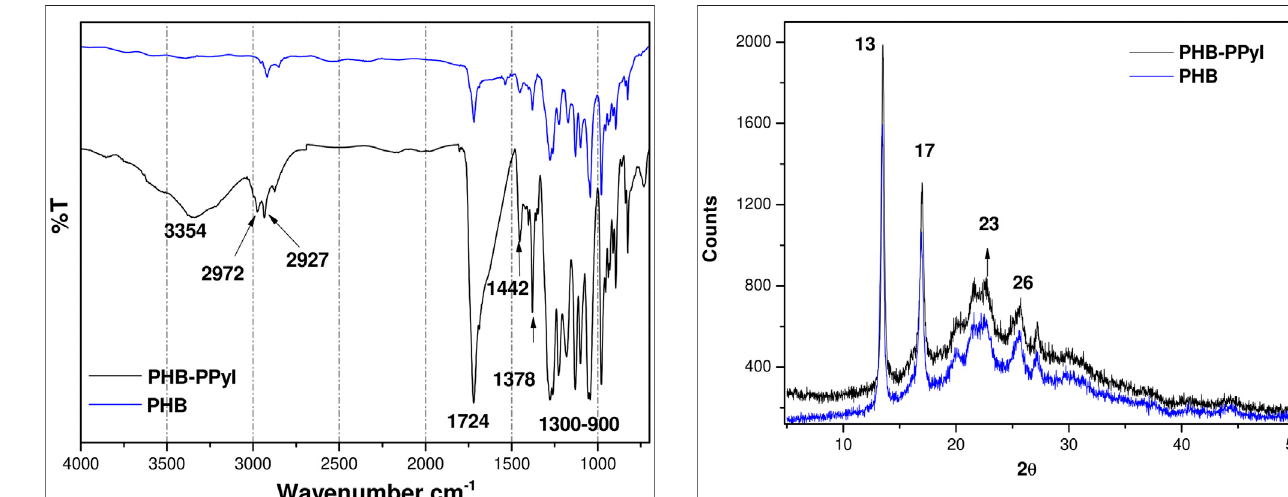
FIGURE 2 | FTIR spectra of PHB and PHB-PPyI scaffolds. Amine groups in PPyI produce the band at 3,354 cm − 1 .